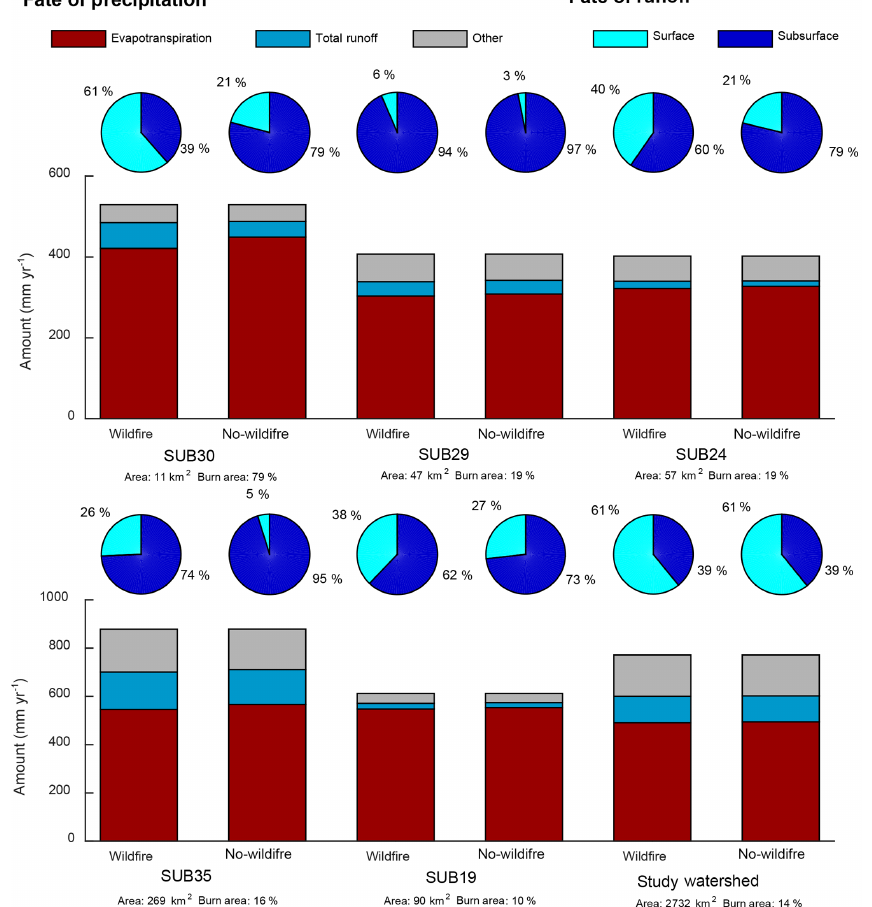
Figure 8. Hydrologic budgets showing the fate of average annual precipitation (i.e., evapotranspiration, total runoff, and other) with the fate of average annual total runoff (i.e., surface and subsurface) for select sub-watersheds and the entire study